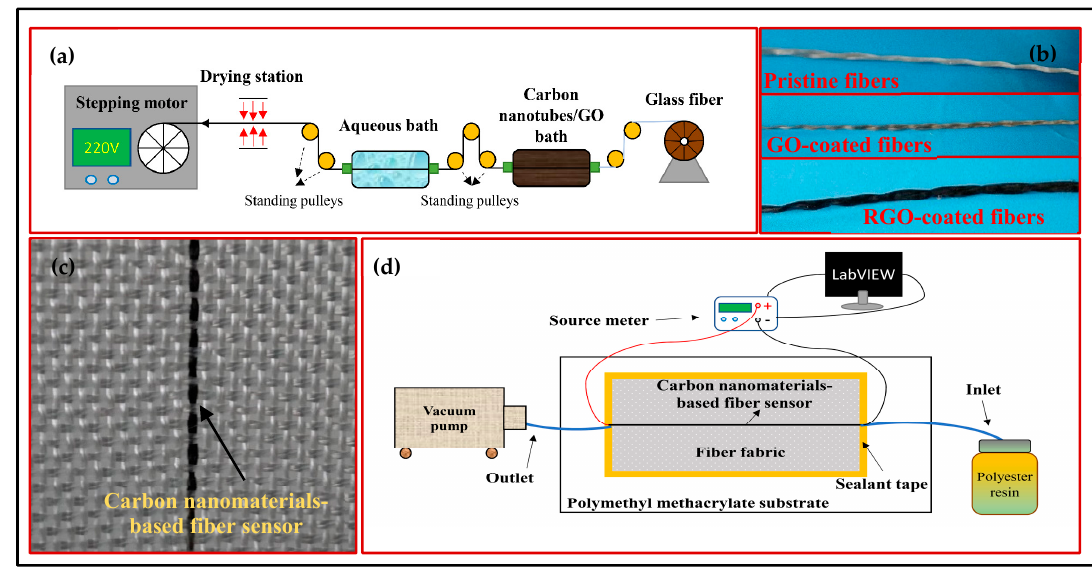
Figure 1. ( a ) Schematic diagram of the fiber winding and coating system. ( b ) Photographs of the pristine, graphene oxide (GO) and reduced graphene oxide (RGO)-coated fibers. ( c ) A representative smart fabric with an embedded carbon nanomaterials-based fiber sensor. ( d ) The schematic diagram of the setup for the monitoring of the vacuum-assisted resin transfer molding (VARTM) process.